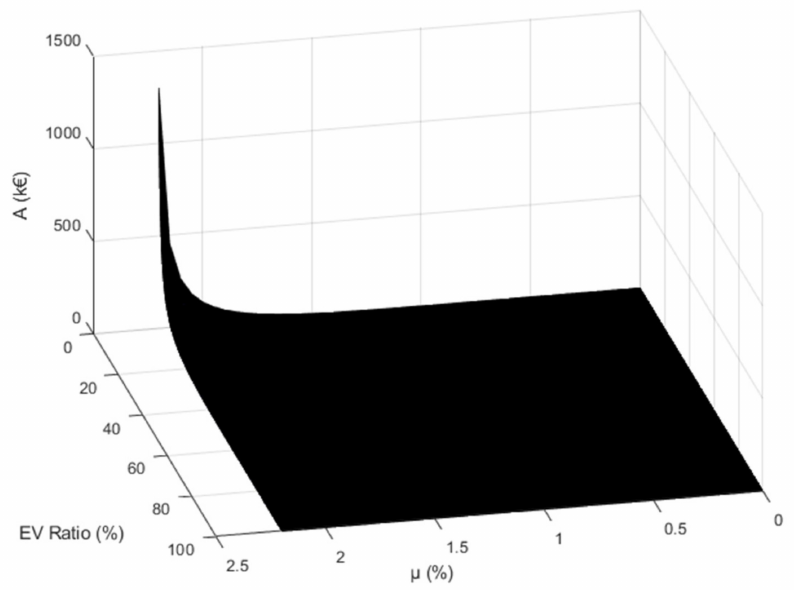
Figure 14. Option value A (k € ) as a function of VE integration (%) and drift rate µ